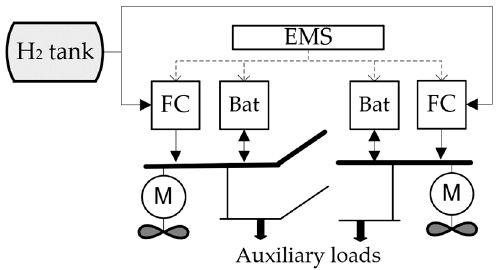
Figure 2. Fuel cell/battery hybrid propulsion system (Source: By author).